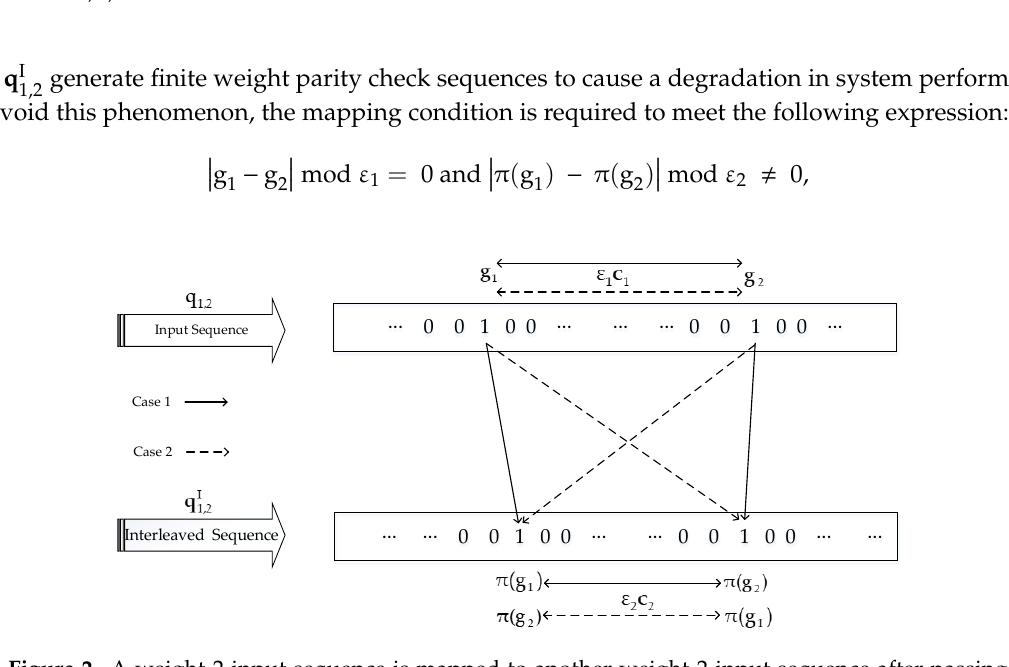
Figure 2. A weight-2 input sequence is mapped to another weight-2 input sequence after passing through the interleaver.